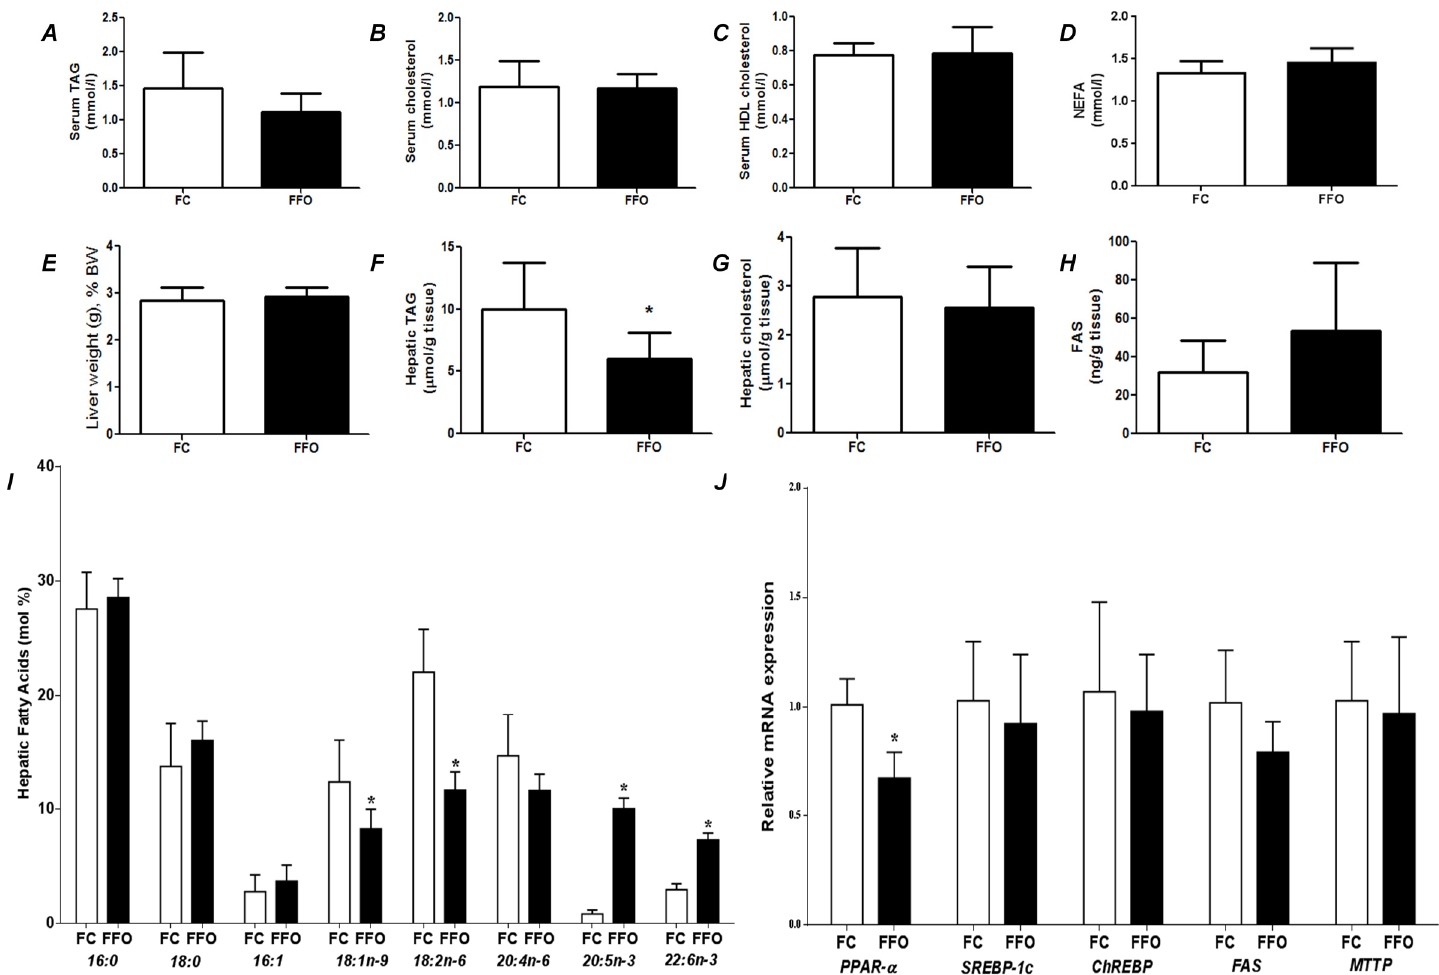
Figure 2. Fasting state parameters of rats fed a control (FC) or fish oil (FFO) diet for 7 days prior to a 48 h fast. ( A ) Serum triacylglycerol (TAG); ( B ) serum total cholesterol; ( C ) serum HDL cholesterol; ( D ) serum non-esterified fatty acids (NEFA); ( E ) liver weight as a percentage of body weight; ( F ) hepatic TAG; ( G ) hepatic total cholesterol; ( H ) hepatic content of fatty acid synthase; ( I ) hepatic fatty acid profile; ( J ) hepatic gene expression (see Figure 1 for abbreviations). * Indicates significantly different from control ( p <